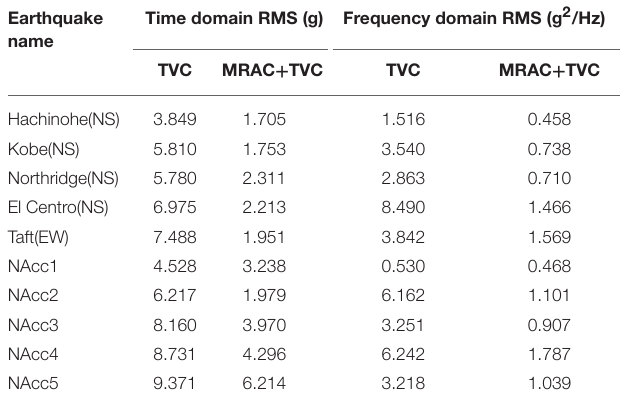
frequency domains. Earthquake